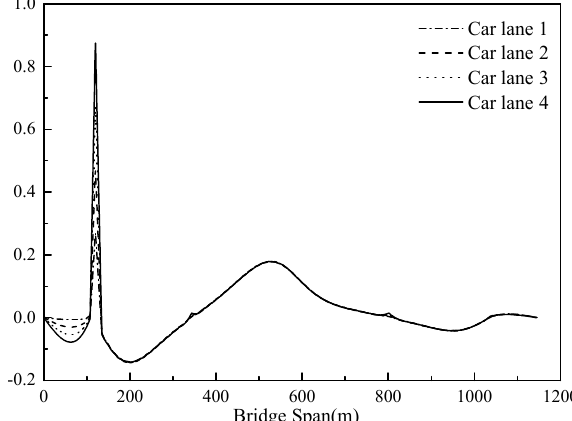
Figure 3. Influence lines of cable 1 on each traffic lane.